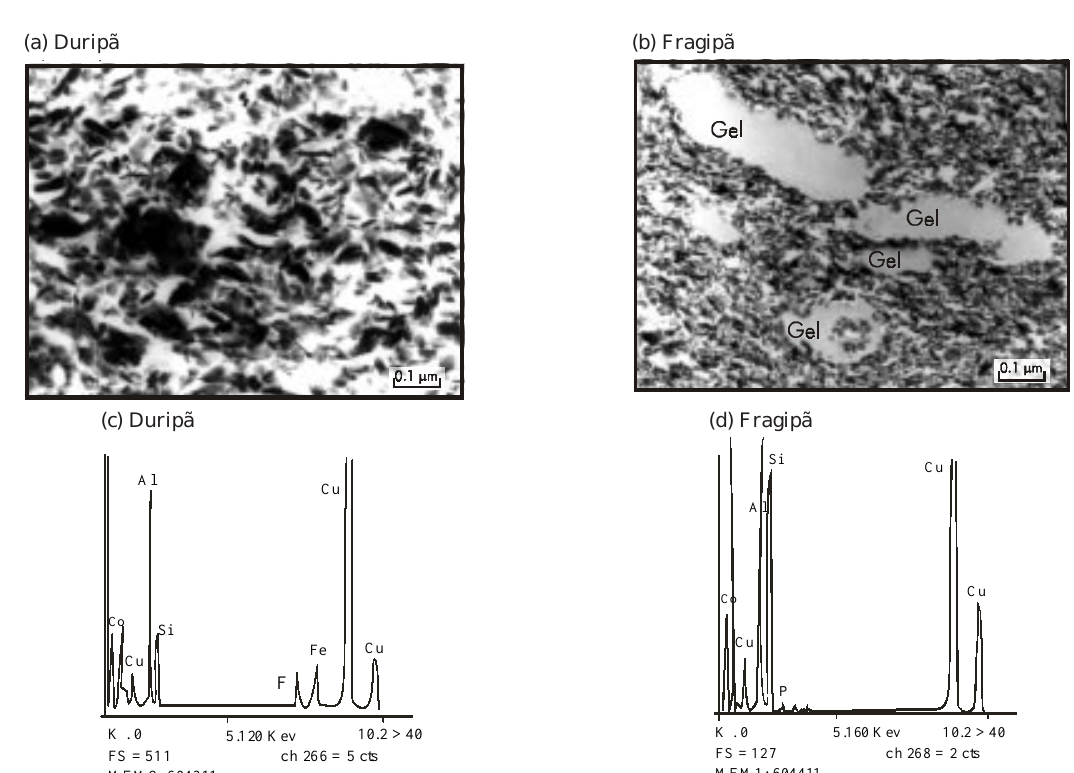
Figura 6. (a) Duripã e (b) fragipã observados em lâmina ultrafina (Microscopia Eletrônica de Transmissão). (c) Duripã e (d) Fragipã: Análise por microssonda acoplada ao Microscópio Eletrônico de